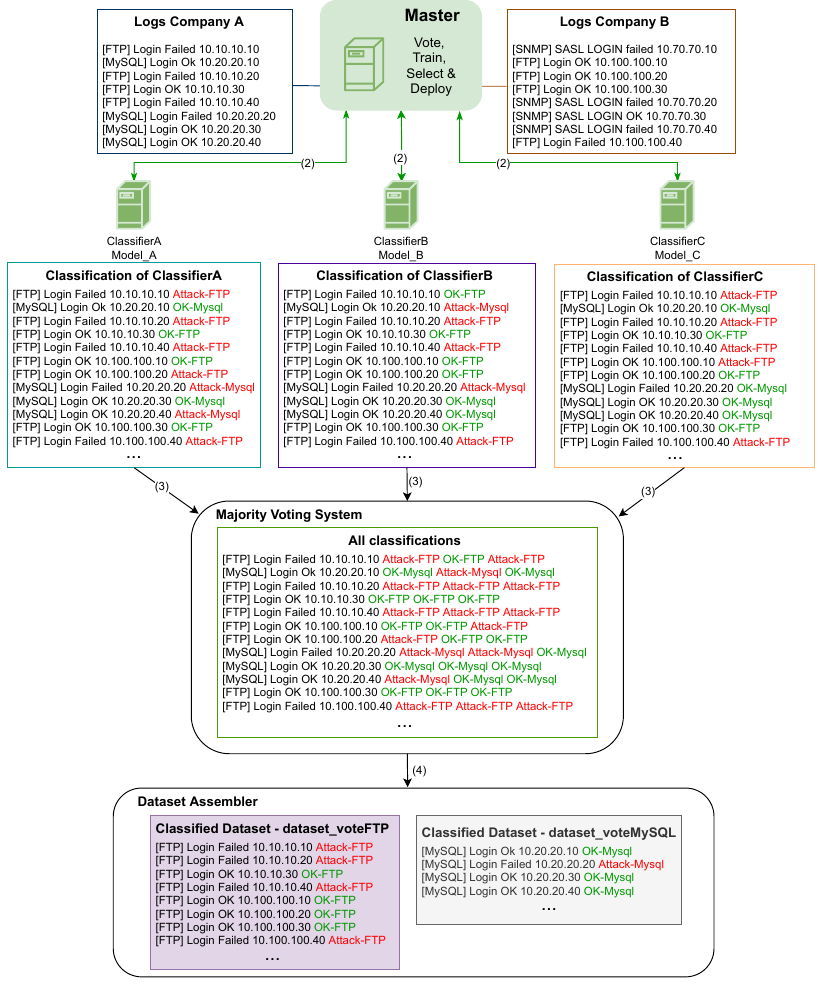
Figure 6. Master internal procedures for classification, voting and dataset